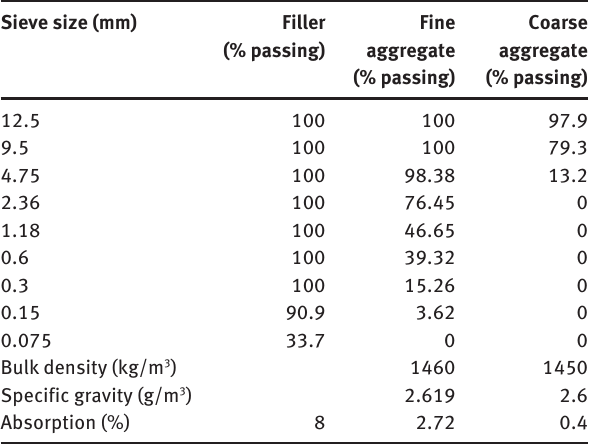
Table 5 Sieve analysis and physical properties of the filler, fine, and coarse aggregates.